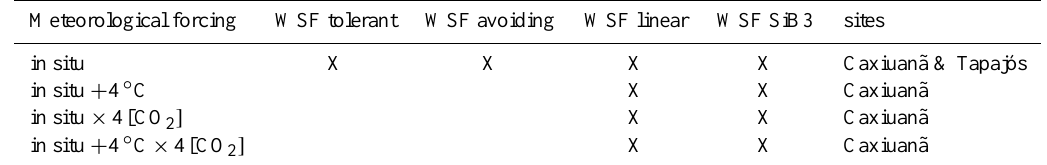
Table 4. Summary of ISBA CC